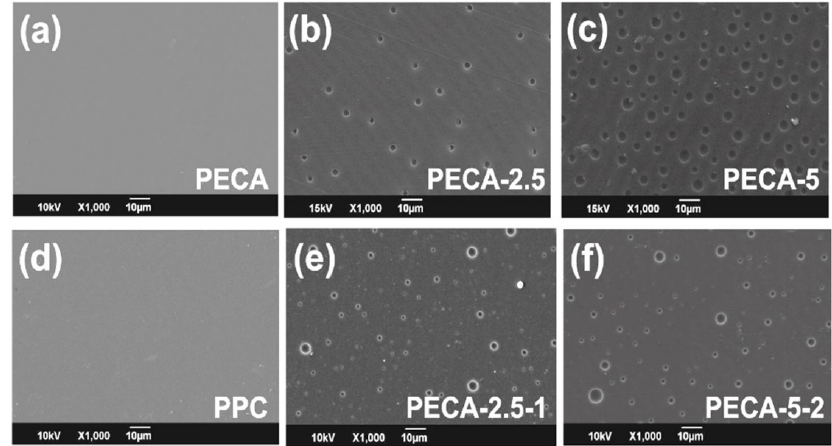
Figure 2. Surface scanning electron microscopy (SEM) images of ( a ) pure PECA, ( b ) PECA with 2.5 of PPC (PECA-2.5), ( c ) PECA with 5.0 wt.% of PPC (PECA-5), ( d ) pure PPC, ( e ) PECA-2.5 with 1.0 wt.% of ca ff eic acid, and ( f ) PECA-5 with 2wt. % of ca ff eic